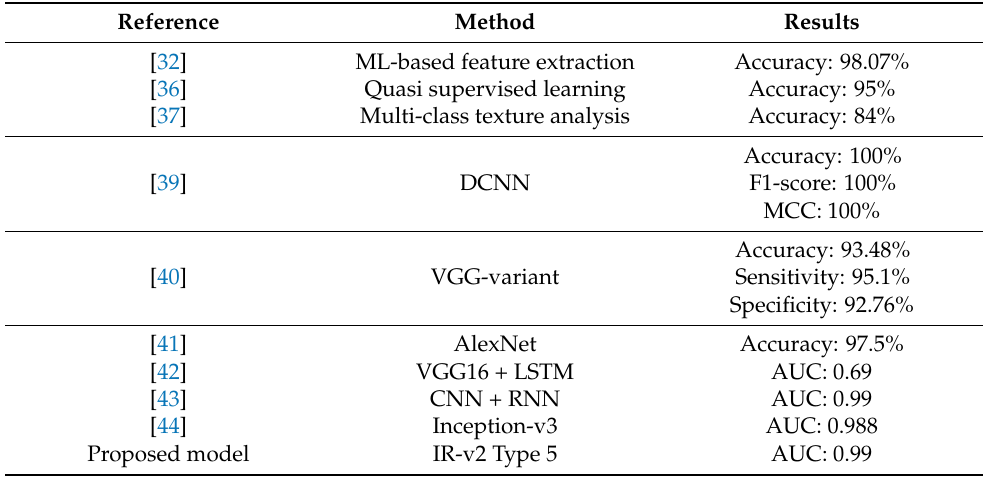
Table 5. Comparison of previous methods with the proposed IR-v2 Type 5 considering colon cancer histopathological WSI.